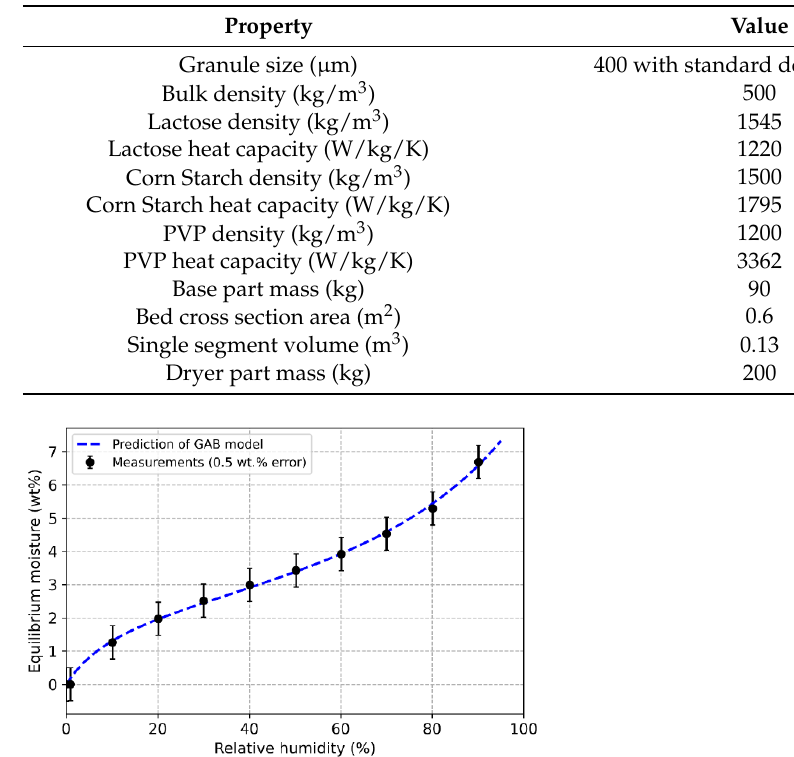
Table 1. Materials and equipment properties.